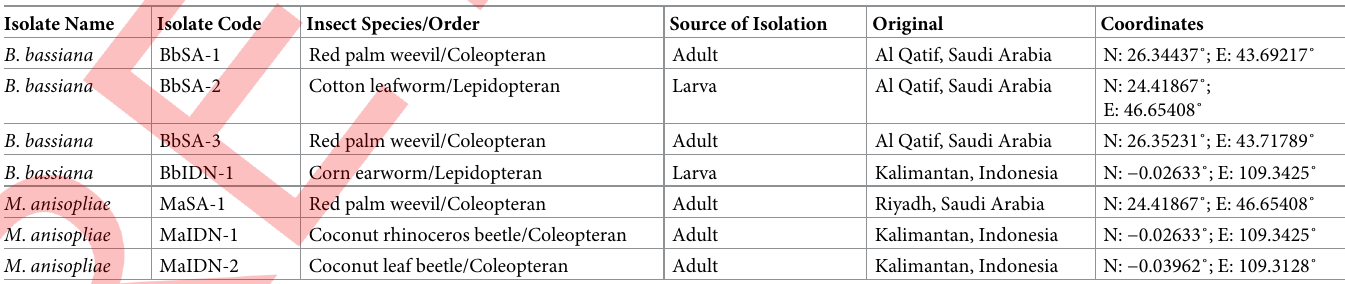
Table 1. Specific information about entomopathogenic fungi isolates used in the present study. Isolate